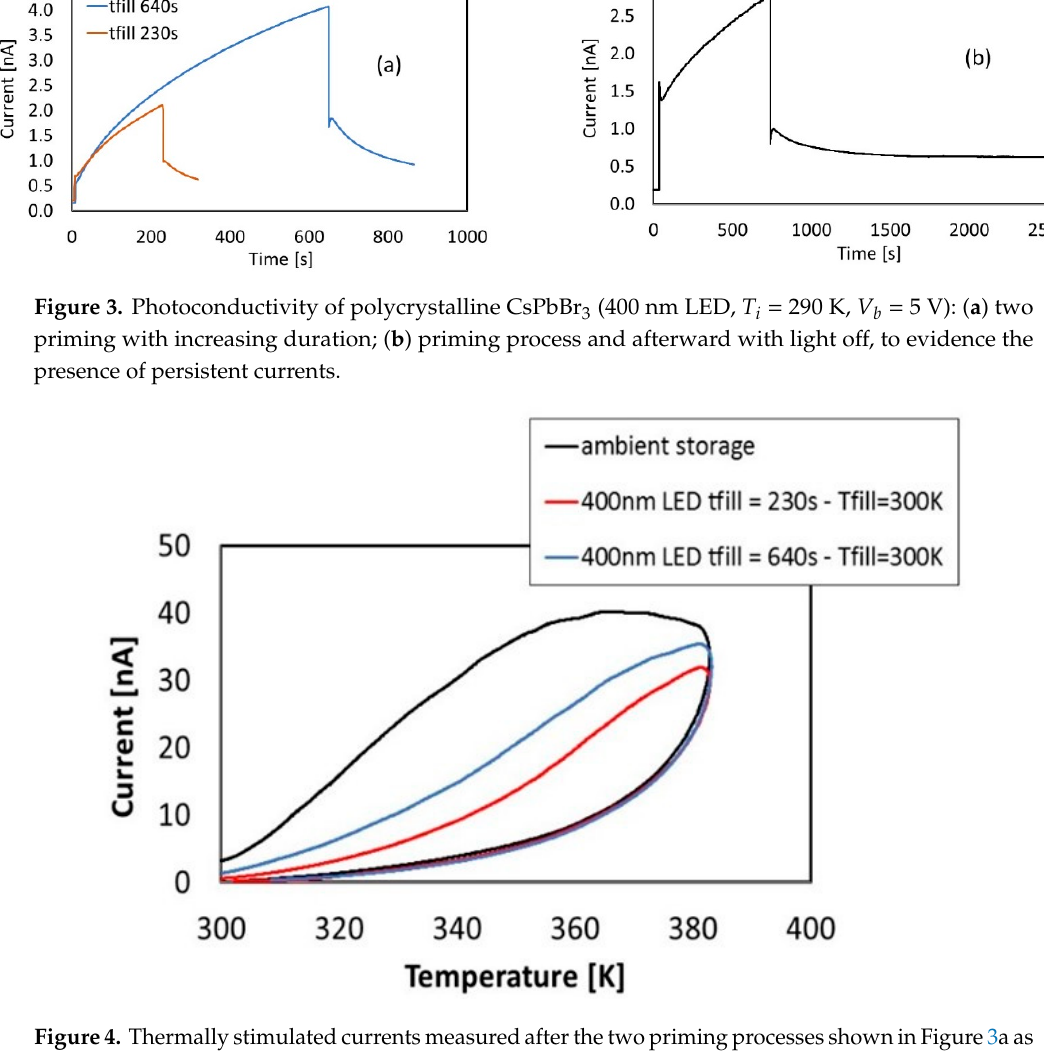
Figure 4. Thermally stimulated currents measured after the two priming processes shown in Figure 3a as compared with the one measured with the same sample after storage in ambient light, same T i = 300 K, V b = 5 V and heating and cooling rate β = 0.08 K/s. Table 2. Energy Levels E t measured of TSC components measured in the range 290-400 K. Trap occupancy TO measured for each energy level depending on the different filling processes at room temperature, A: long term storage; B: filling time 230 s; C: filling time 640